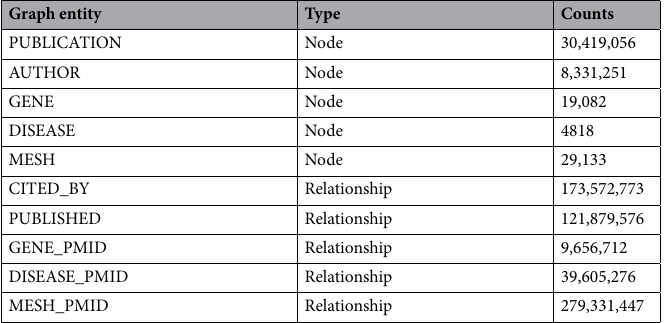
Table 6. Database profiling. We loaded PubMed 2019 base-line into Neo4J, an open source graph-database management system. We introduced four node types (PUBLICATION, AUTHOR, GENE, DISEASE), and four edge types (PUBLISHED, from AUTHOR to PUBLICATION; CITED_BY between PUBLICATION, GENE_PMID_ASSOCIATION from GENE to PUBLICATION; and DISEASE_PMID_ASSOCIATION from DISEASE to PUBLICATION). Furthermore, PUBLICATION nodes have the following attributes: PMID, TITLE, ABSTRACT, AFFILIATIONS, IS_REVIEW, IS_CLINICAL_TRIAL, BIG_PHARMA, MEDIUM_ PHARMA and DATE. The database is accessible at: https:// mega. nz/ file/ 4E8Qj CaQ# oqtm7 jof- lsG7y Sget8 uakh7 m26bD Lo1Hr Pu3mt